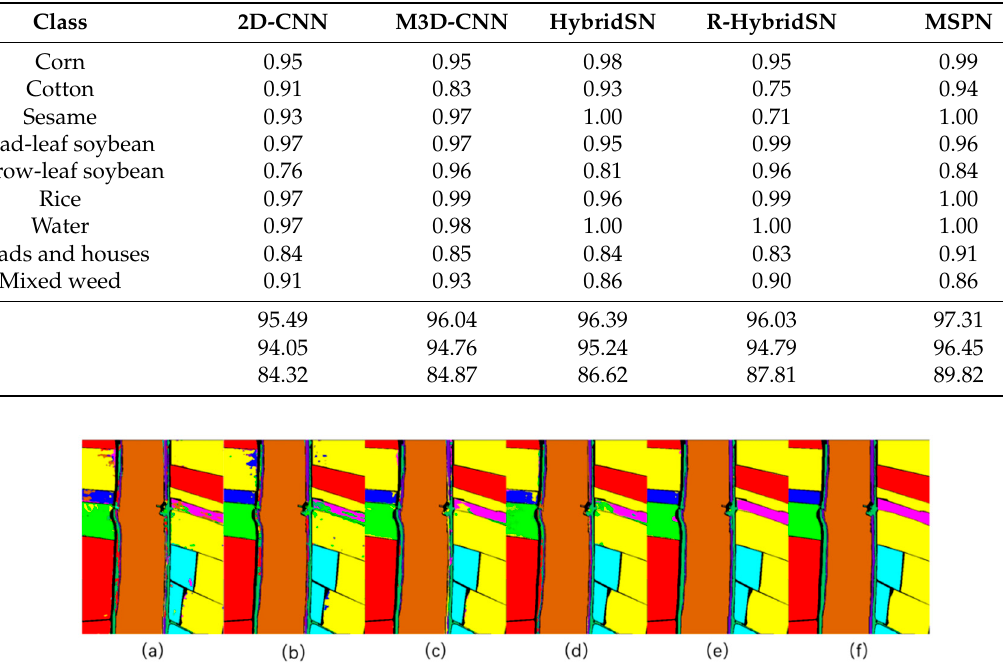
Table 6. Accuracy comparison of different methods for 0.1% samples from the WHU-Hi-LongKou dataset.